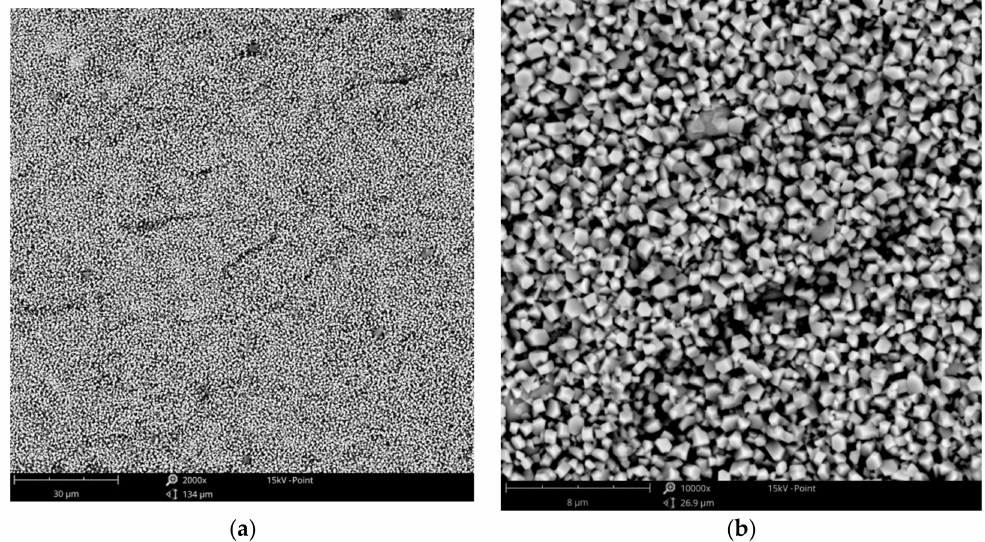
Figure 6. SEM images of the Zn coating electrodeposited in the bath with 800 g · L − 1 of ZnAc at a temperature of 100 ◦ C (j c = 3 mA · cm − 2 , t = 15 min) at low ( a ) and high ( b )